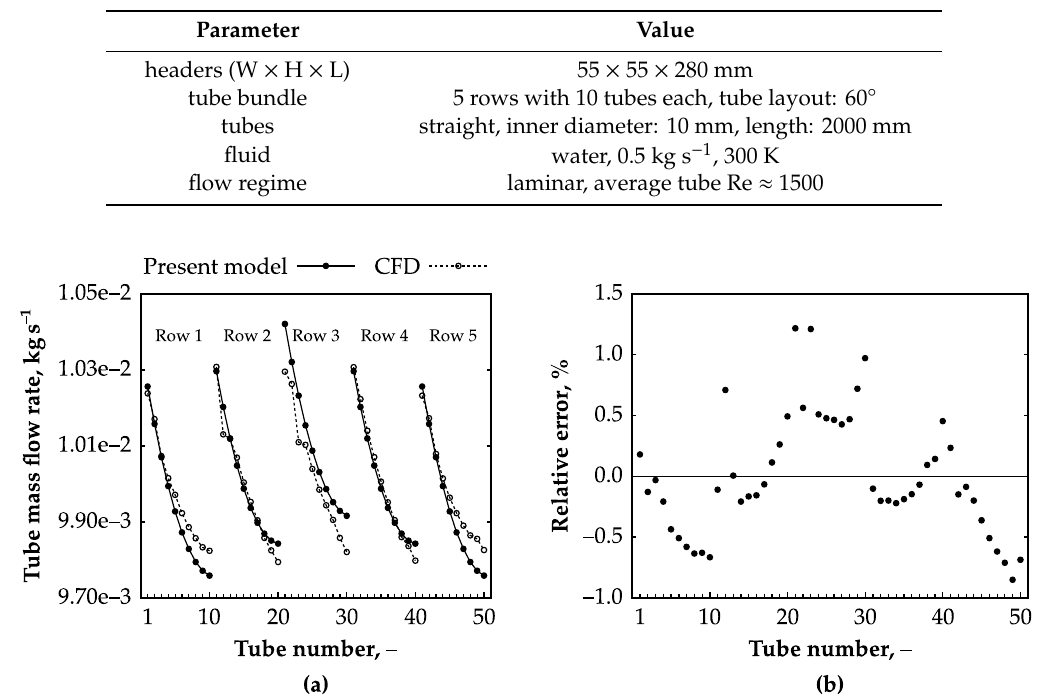
Figure 2. ( a ) Tube mass flow rates obtained for the flow system from Table 1 using the model based on Finite Element Analysis (FEA) discussed in [26] and a transient Computational Fluid Dynamics (CFD) simulation. Average tube Reynolds number was ca. 1500. ( b ) The corresponding relative tube mass flow rate errors (FEA vs. CFD simulation). Tube numbers correspond to Figure 1. For the details regarding the CFD model, the reader is kindly referred to [27].